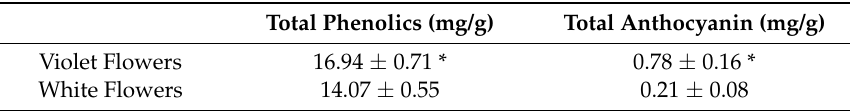
Table 2. Total polyphenolic and anthocyanin contents in ethanol extracts of white flowers of M. denudata and violet flowers of M. liliiflora